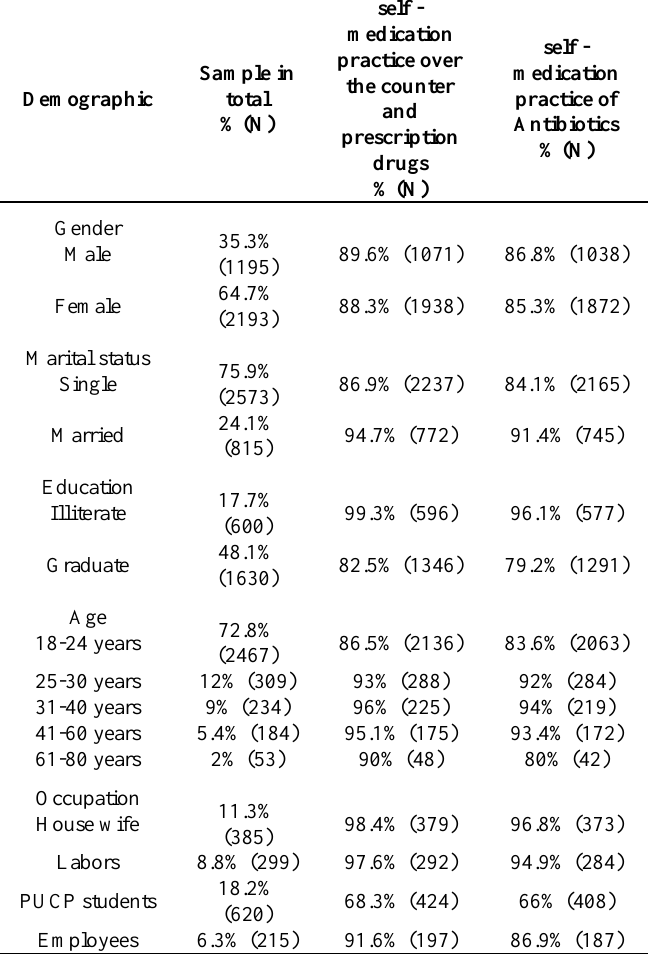
Table 2: Self-medication practice among general population as well as in all study groups